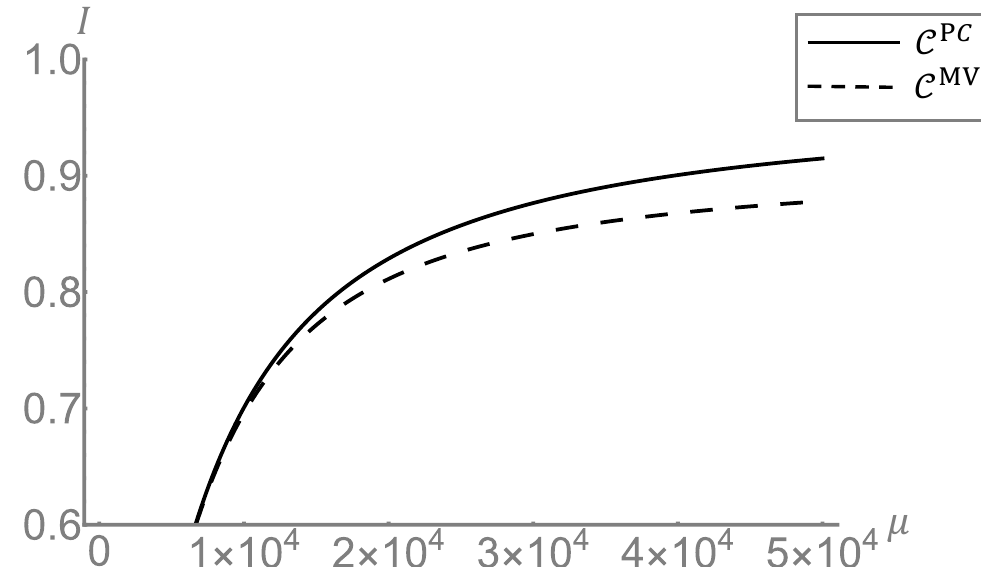
Figure 5. Post-processing comparison. We show the information retrieved by a classical transmitter and photon counting as a function of the mean number of signa photons µ . We consider two maximum likelihood post processing, one C PC , with full information on the distributions of T 0 , and T 1 , as discussed in the main text, and the other C MV using only the mean values of the distributions ¯ τ 0 and ¯ τ 1 . The parameters are fixed to ¯ τ 0 = 0.925, σ 0 = 0.005, ¯ τ 1 = 0.965 and σ 1 =